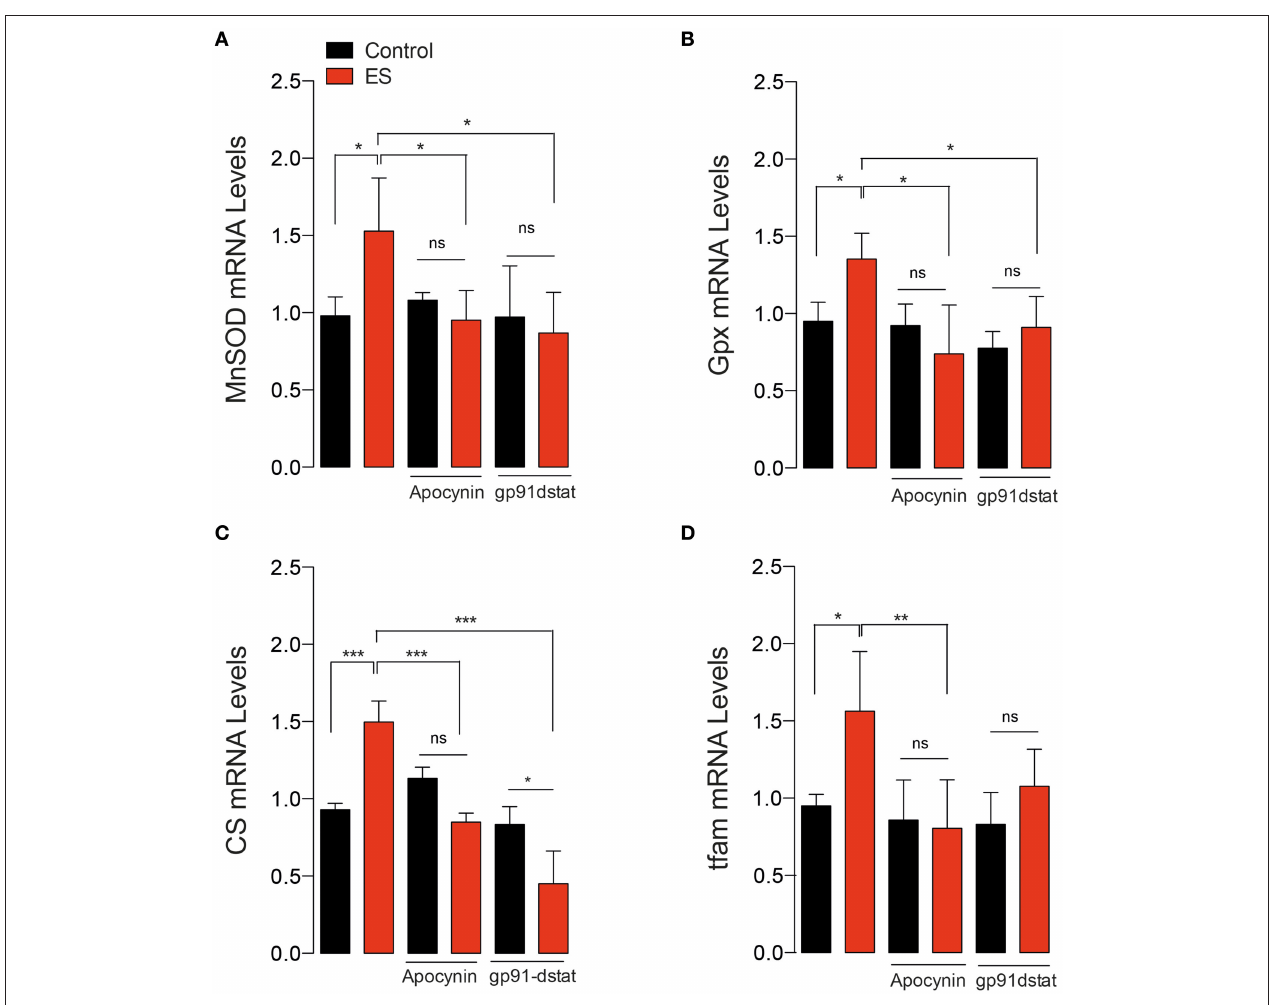
FIGURE 5 | In vitro electrical stimulation-induced gene expression in a NOX2-dependent manner. (A) Levels of mRNA for manganese superoxide dismutase (MnSOD), (B) Glutathione peroxidase (Gpx), (C) Citrate synthase (CS) and (D) Mitochondrial transcription factor A (tfam). Gene transcription was assessed by real time PCR in isolated skeletal muscle fibers in the presence and absence of the NOX2 inhibitor gp91-dstat before electrical stimulation (ES). Data are expressed as mean ± SD from five different determinations. * p < 0.05 , ** p < 0.01 , *** p < 0.001 ; ns, no significant difference, one-way ANOVA-